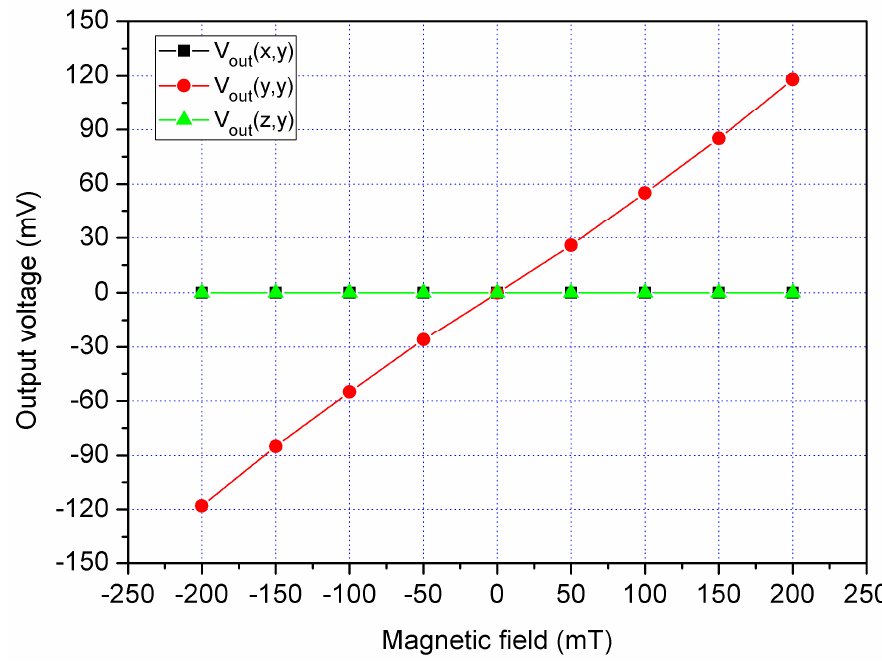
Figure 6. Simulation of output for the MS in the x-direction MF.